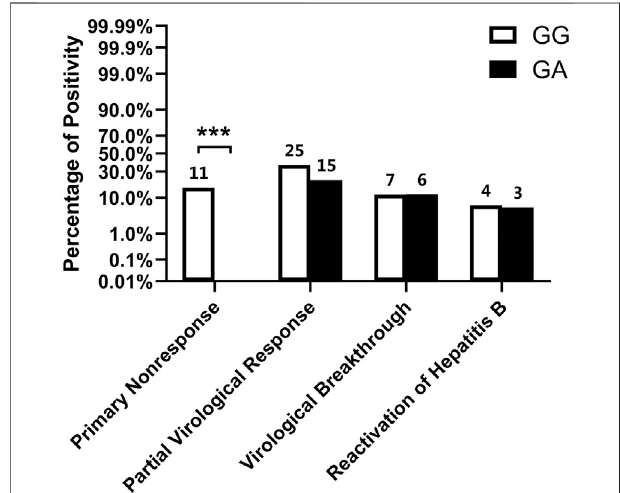
FIGURE 2 | Virological outcome of patients using First-line NAs. Numbers above the bar indicate the speci fi c frequency (ie., raw number of patients who were primary nonresponse in wild type controls).* p < 0.05, ** p < 0.01, *** p <